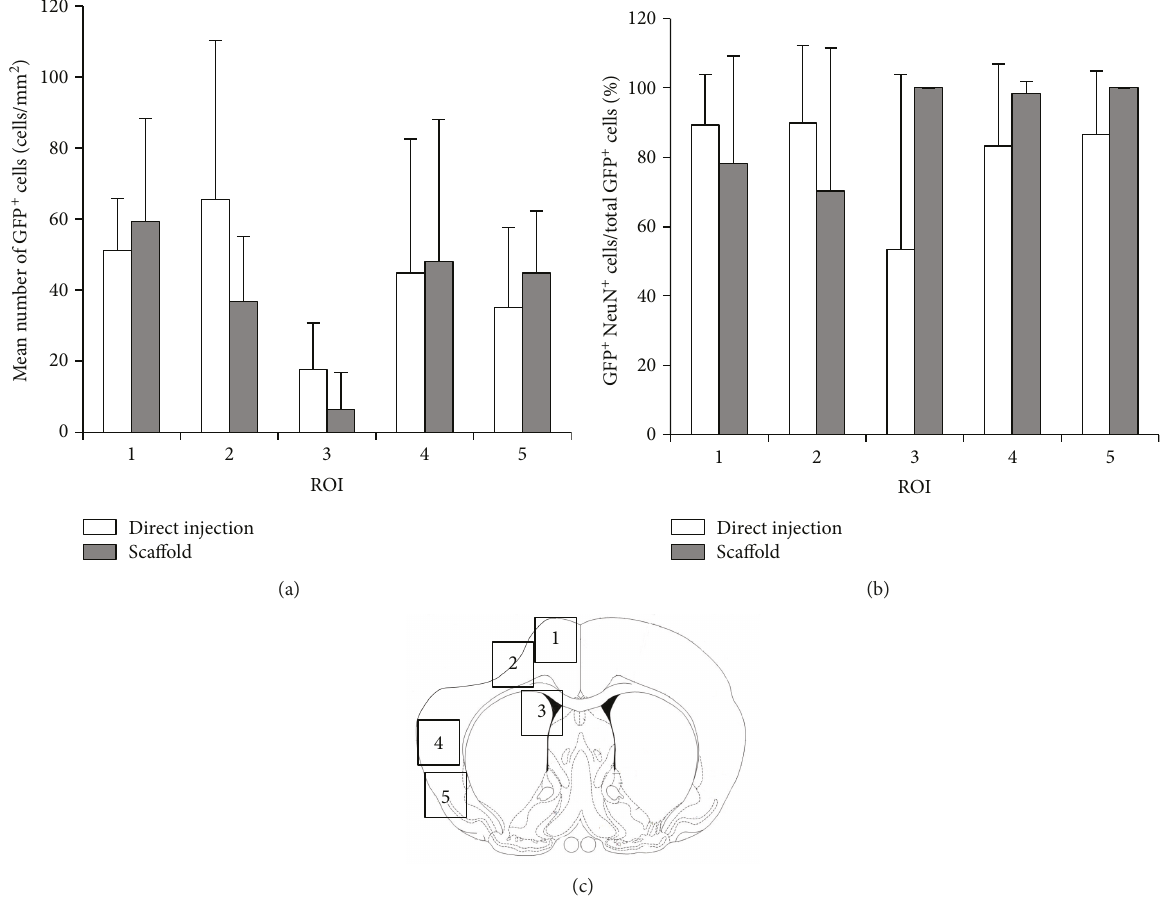
Figure 3: Histological analysis. The bar graphs show the mean number of GFP-positive cells (a) and the percentage of GFP and NeuN double-positive cells in the total GFP-positive cell population (b) in each ROI. Panel (c) indicates the location of each ROI. White bars: the BMSC/direct injection group; shaded bars: the BMSC/sca ff old group. Error bars show